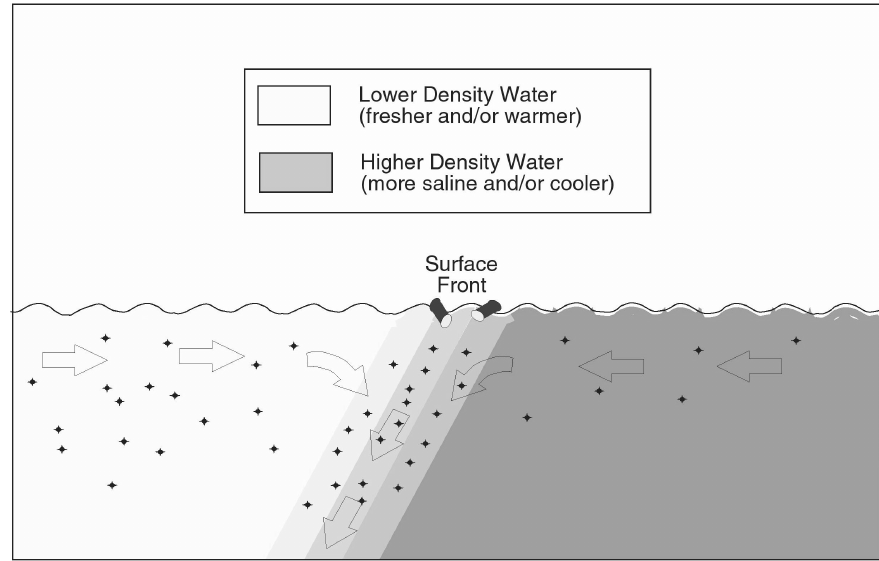
F IG . 1. – Schematic diagram of a front between waters of differing density. Arrow-shaped symbols indicate density-driven flows associated with the front. “Particle” symbols signify planktonic organisms capable of resisting being carried downward in the sinking water motion. (Scales are distorted: vertical scale greatly expanded relative to horizontal; particles greatly magnified; surface waves not to scale, etc.) After Bakun